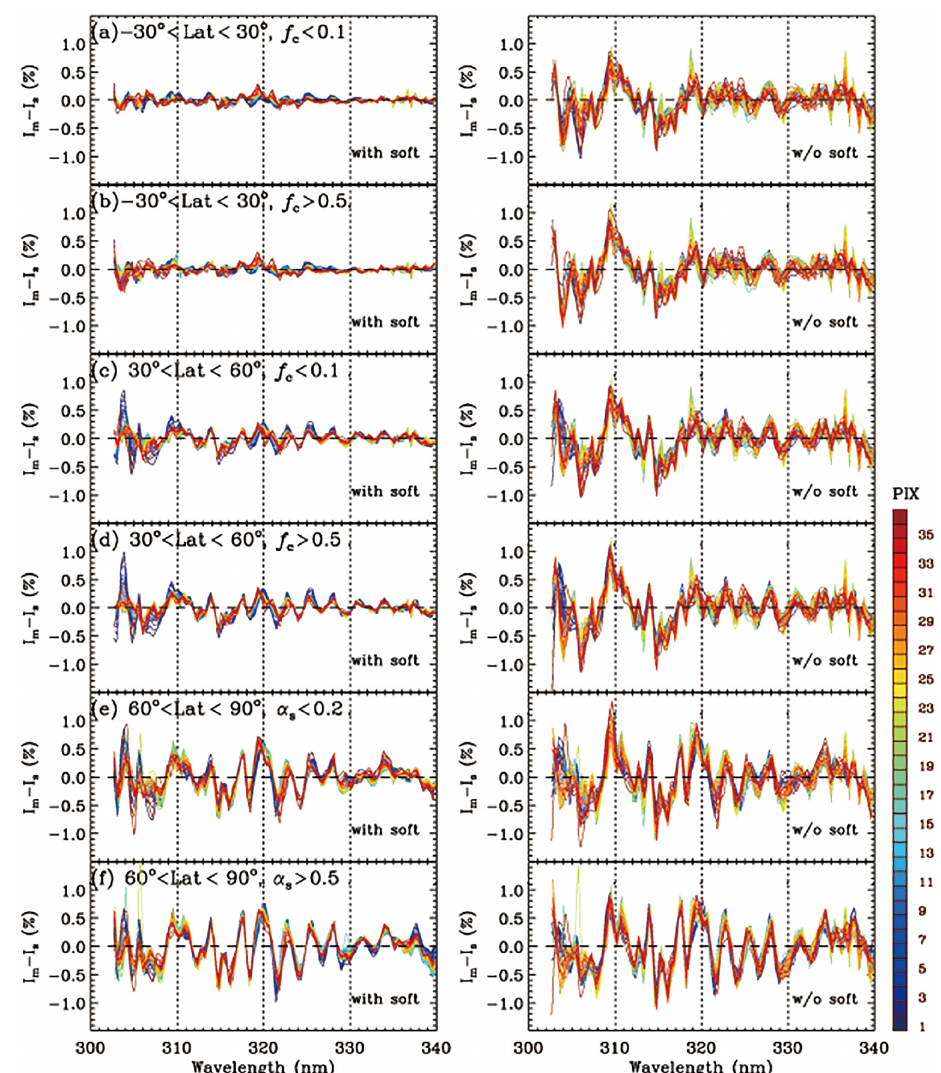
Figure 8. Comparison of fitting residuals on 14 March 2013 with (left) and without (right) soft calibration for six cases: (a–b) Tropics and (c–d) midlatitudes each for clear sky (effective cloud fraction, fc<0.1) and cloudy (fc>0.5) conditions and (e–f) high latitudes for snow-free and snow-covered surface conditions. Different colors represent different cross-track